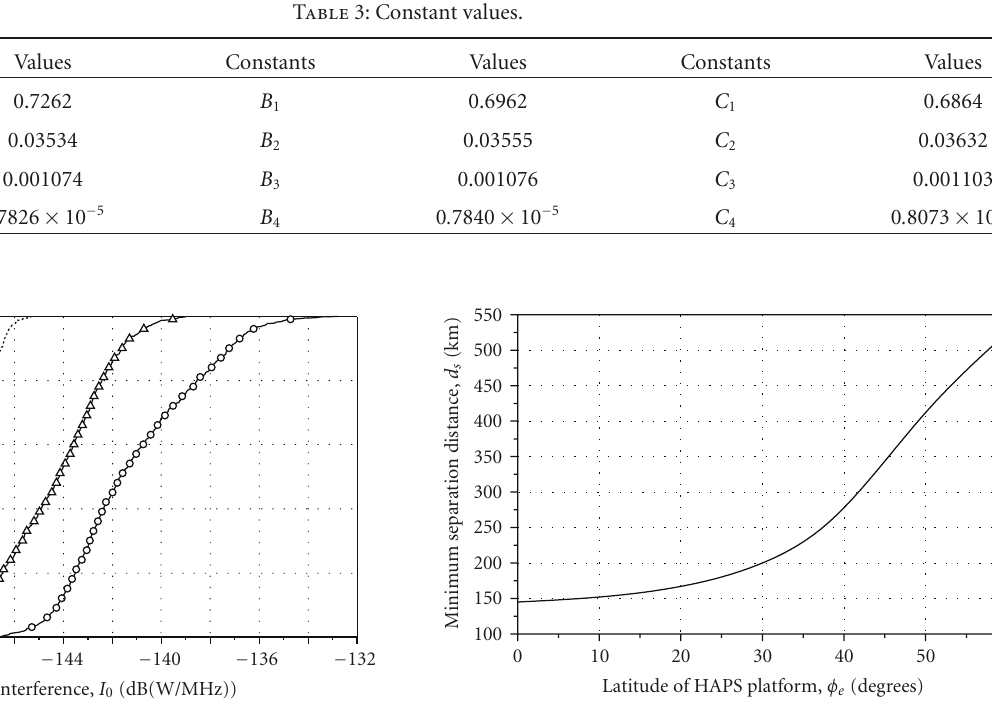
Figure 7: Separation distance with the latitude of the HAPS platform φ e